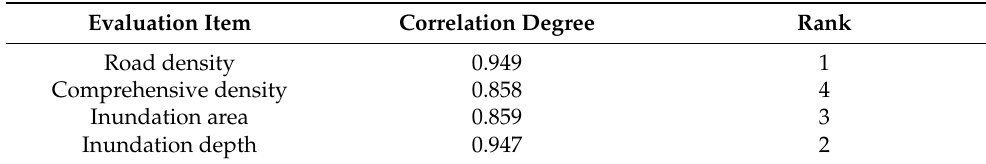
Table 2. Correlation result.